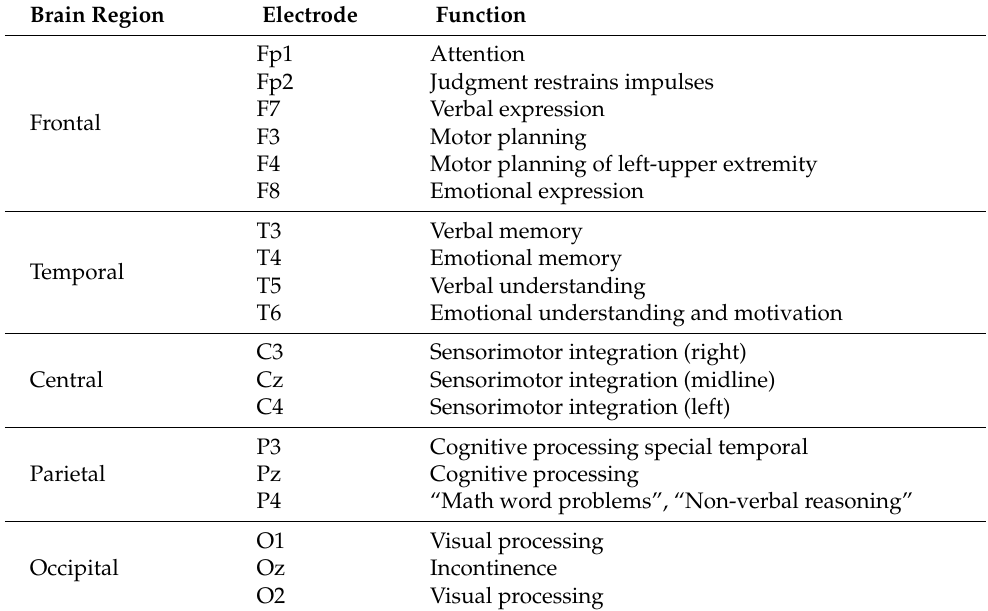
Table 1. Nomenclature and functions for the electrodes in the international 10–20 system, Syakiylla et al.